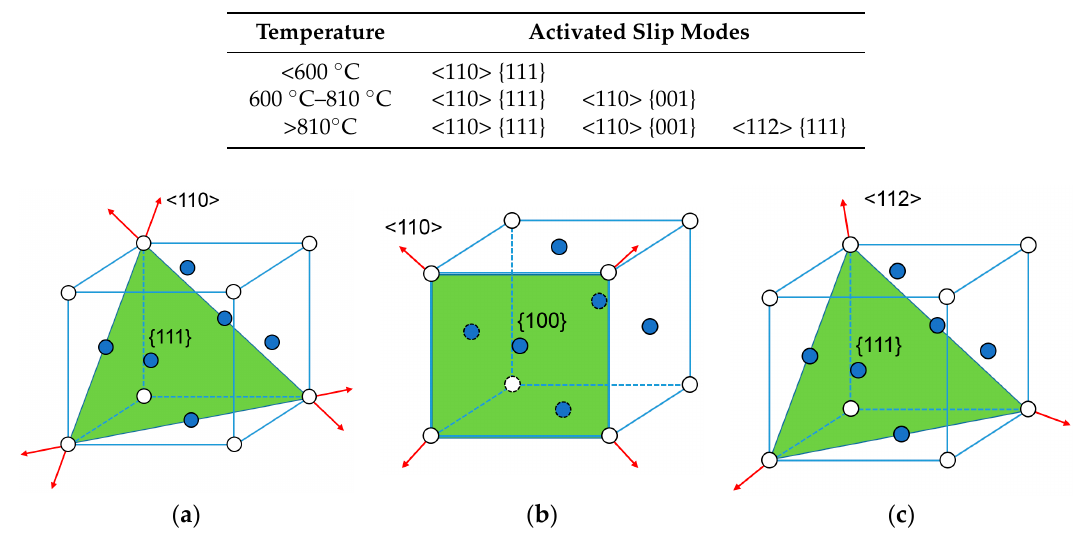
Figure 2. Schematic illustration of activated slip system in face-centered cubic metals at various temperature: ( a ) <110> {111}; ( b ) <110> {001}; ( c ) <112> {111}. temperature: ( a ) <110> {111}; ( b ) <110> {001}; ( c ) <112>